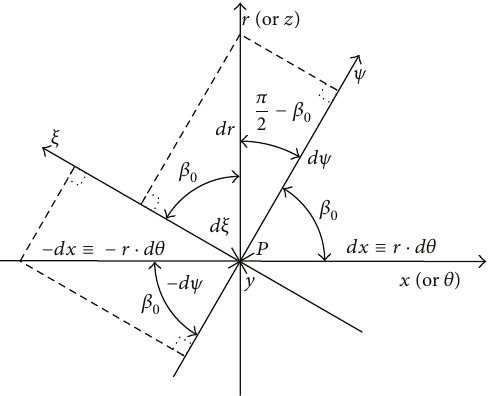
Figure 3: Relations between the general and local coordinate systems (in an arbitrary point, P ). At point P , the coordinate 𝜉 is normal to the 𝜓 direction of the spiral